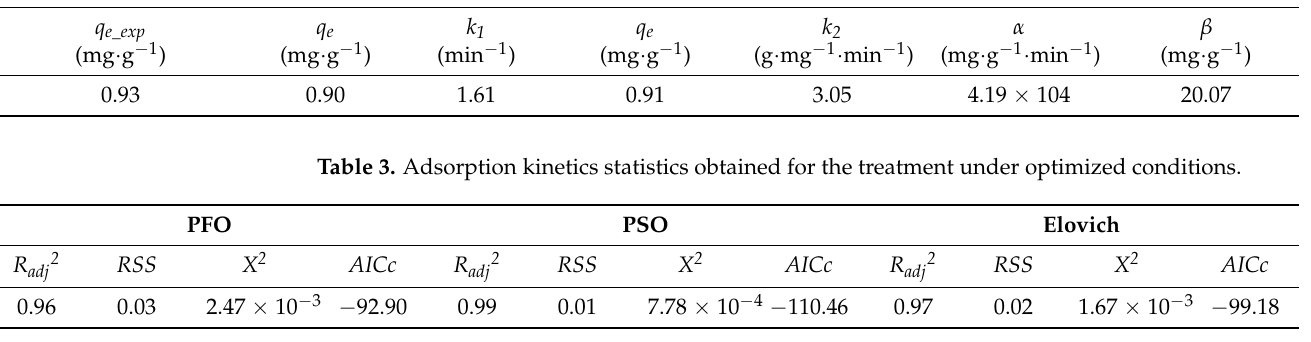
Figure 6. Experimental results and adsorption kinetics modeling for the treatment of 10 mg · L − 1 MR with 10 g · L − 1 CaSF at 20 ◦ C, stirring the system at 100 rpm. Table 2. Adsorption kinetics parameters obtained for the treatment under optimized conditions. Experimental Result